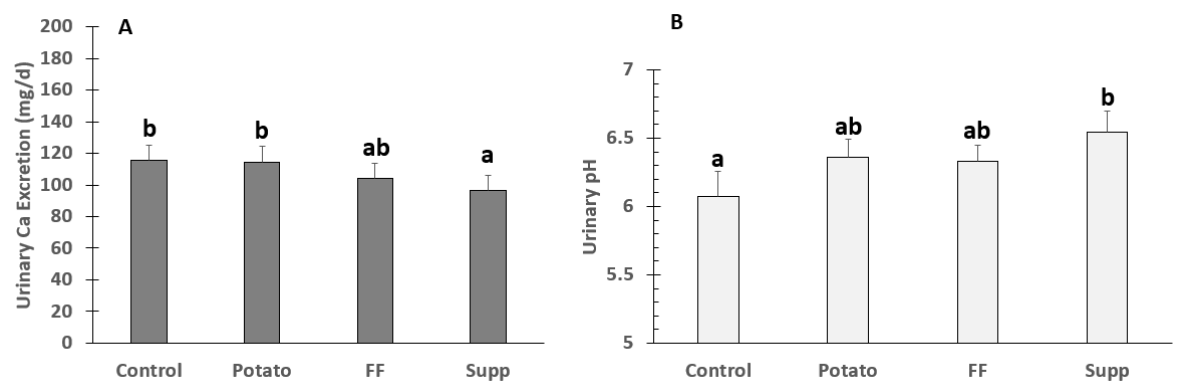
Figure 2. Means ± SE of ( A ) urinary Ca Excretion ( n = 28) and ( B ) pH ( n = 30) in adults fed controlled diets of lower (control) and higher potassium as potato, French fries (FF), or K gluconate (Supp). Different superscript letters denote significant differences ( p < 0.05) by ANOVA.